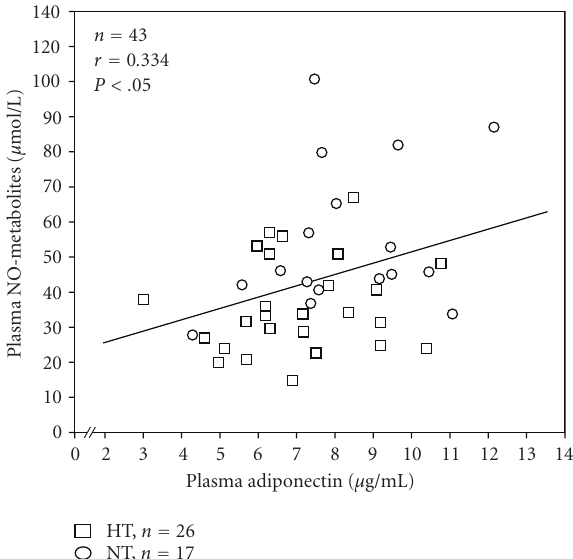
Figure 5: Inverse correlation between plasma 8-iso-PG F2 α and plasma nitric oxide (NO) metabolite levels in hypertensive and normotensive men.